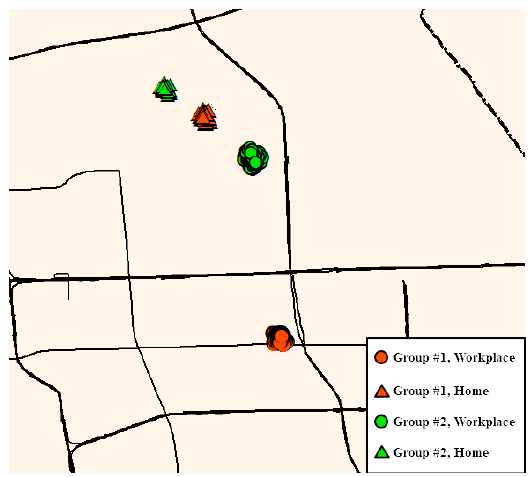
Figure 8. Grouping individuals based on the similarity of their visits to both their homes and workplaces.